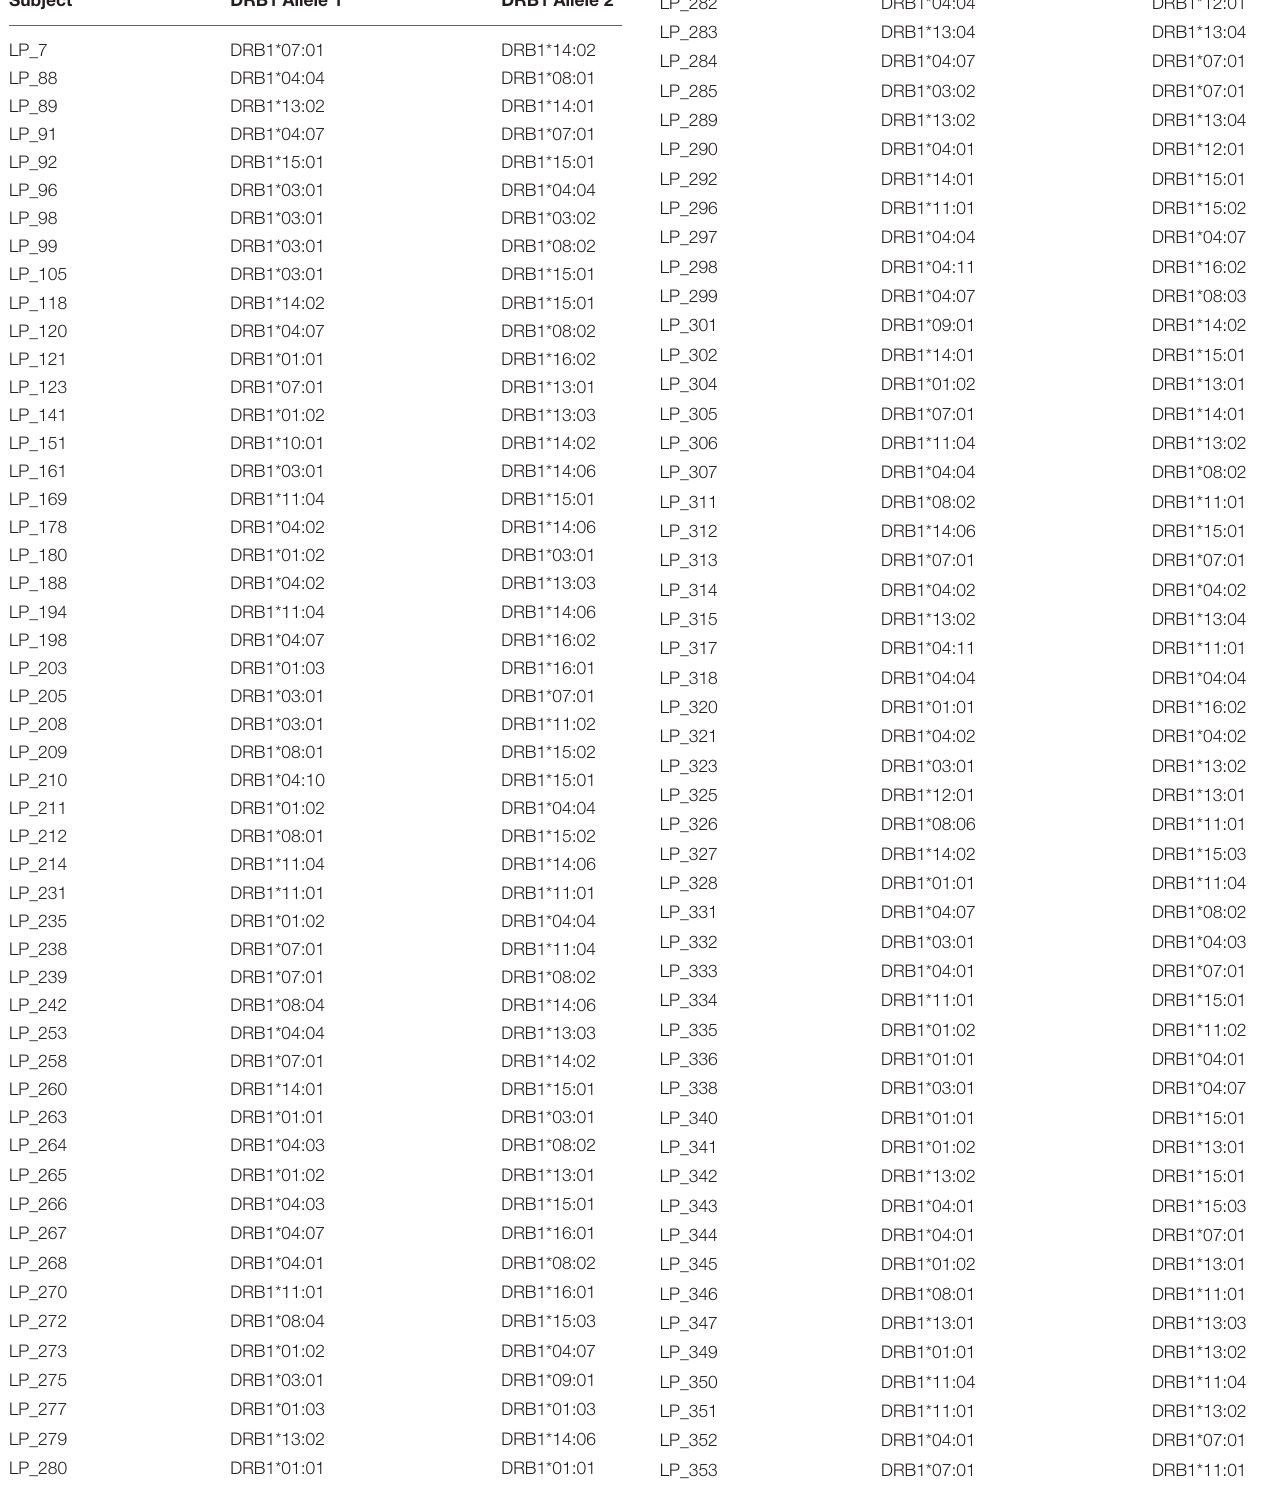
TABLE 2 | All available samples from the CTL ePBMCR Searchable Database v1.2.6 were used as an example of available donors to use in the selection